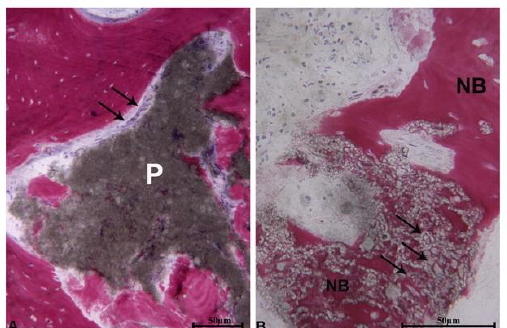
Figure 6. ( a ) A rim of osteoblasts (black arrows) depositing osteoid matrix was observed close to